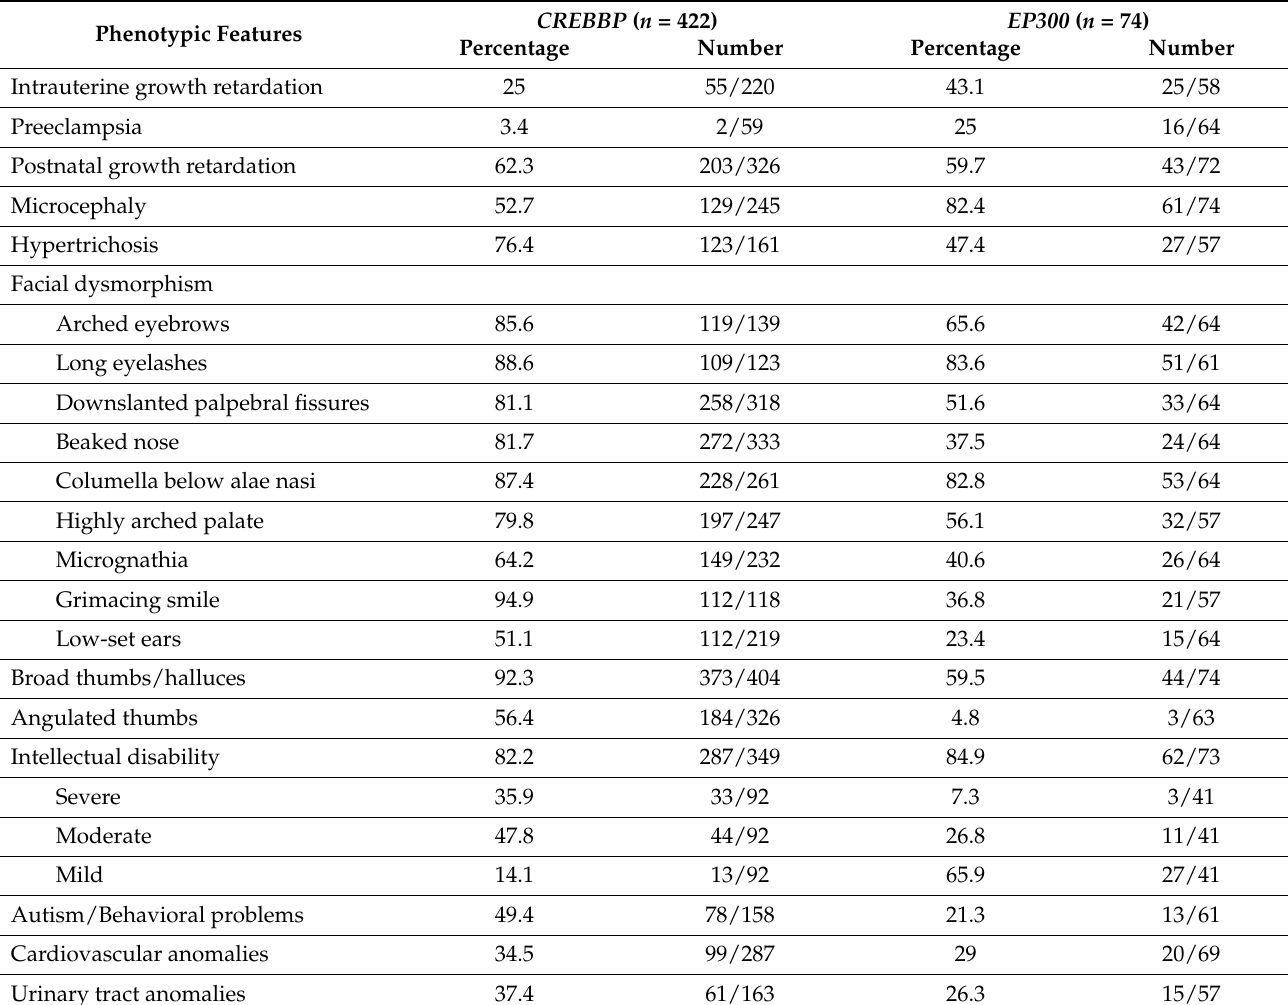
Table 1. Summary of the main phenotypic features in RSTS individuals carrying a CREBBP mutation compared to RSTS individuals with an EP300 mutation reported in the literature. According to Fergelot et al., Yu et al., P é rez-Grijalba et al., Cross et al. , and Cohen et al.